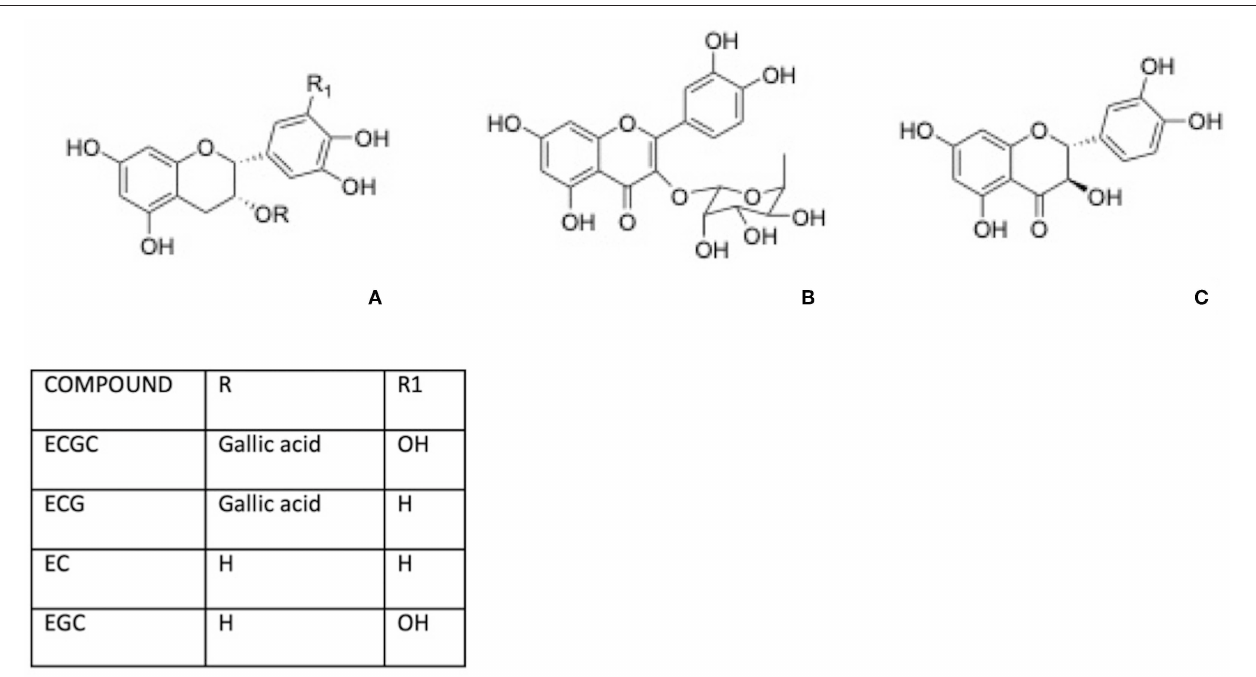
FIGURE 2 | (A) Structures of main green tea polyphenols. (B) Quercitrin. (C)